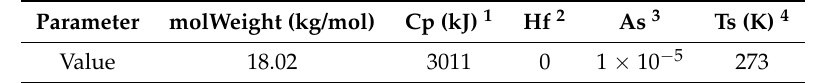
Table 1. The steam in high speed has different characters to gas at room temperature like low density and high specific